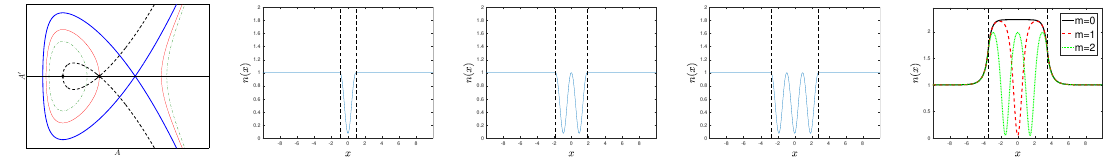
Figure 4. Leftmost panel: orbits in the space ( A , A (cid:48) ) corresponding to Equation (59). The thick dashed black line gives the possible solutions outside the well with amplitude energy E 1 . The dashed-dotted green line describes the arbitrary oscillatory solution inside the well, while the solid red line corresponds to the limit solution within the well that matches the homogeneous subsonic plane wave outside of it. The solid thick blue line marks the limit orbit associated with the subsonic fixed point, analogous to that of the dashed curve, inside the well. Central panels: density profile of ψ H m ( x ) , m = 1,2,3 for = 3.7137 and X H = 5.5705. The vertical = 1.8568, X H v = 0.5, corresponding to well lengths X H 2 3 1 dashed lines mark the limits of the square well. Rightmost panel: density profile of ψ SH m ( x ) , m = 0,1,2 for v = 0.5 and X =